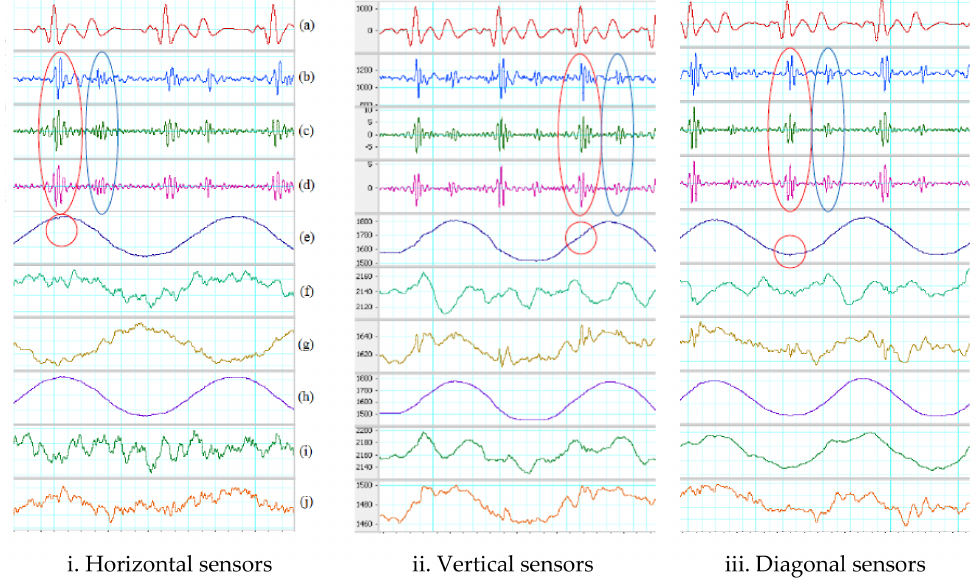
Figure 10. Digital processing on gentle movement. ( a ) Filtered ECG (5–20 Hz). ( b ) Filtered SCG with SUBTRACTOR (subtraction). ( c ) Filtered total acceleration. ( d ) Filtered z-axis acceleration. Red oval indicates a recognized systole. Blue oval indicates a determined diastole. ( e ) First sensor z-axis. Red circle indicates a small SCG signal. ( f ) First sensor y-axis. ( g ) First sensor x-axis. ( h ) Second sensor z-axis. ( i ) Second sensor y-axis. ( j ) Second sensor x-axis. Table 6. Signal measurements of two sensors with digital processing on walking motion.